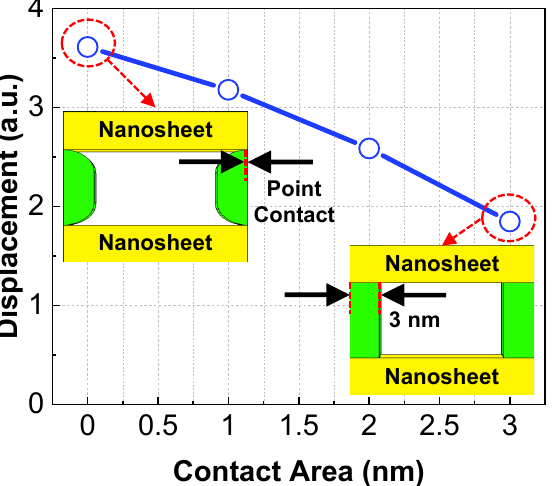
Figure 6. Extracted mechanical displacement with inner space geometry. T INN was fixed at 3 nm.